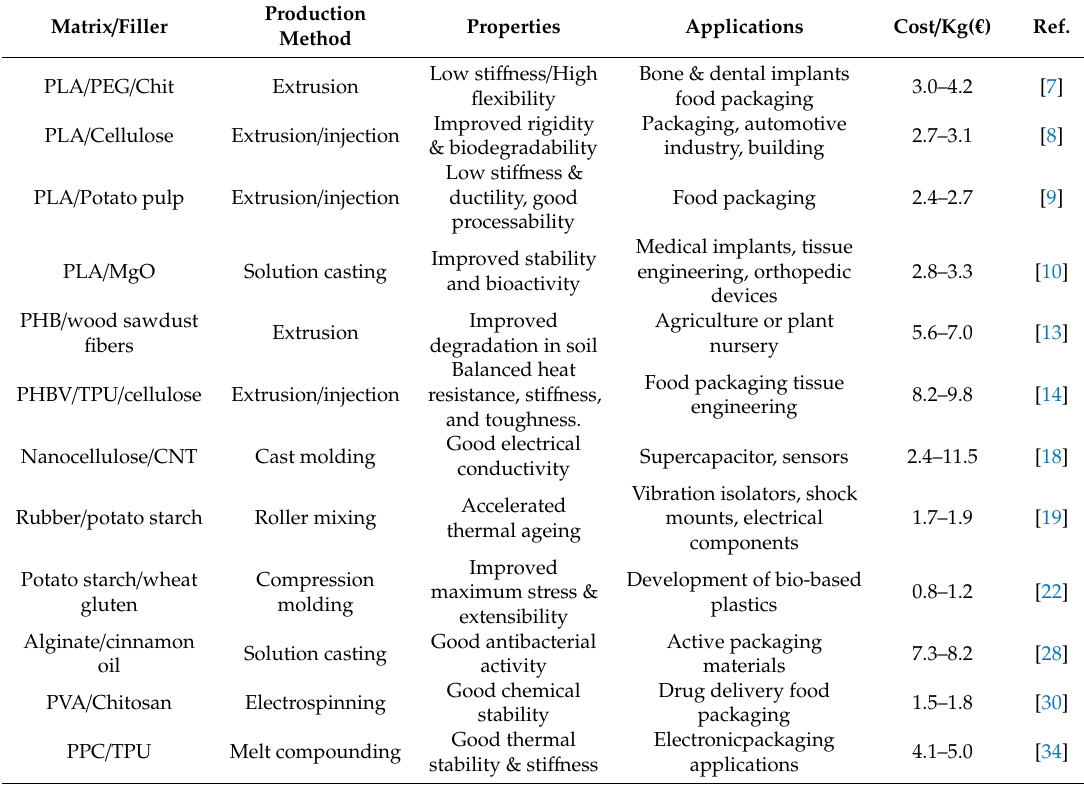
Table 1. Summary of biopolymer composites properties, applications, and